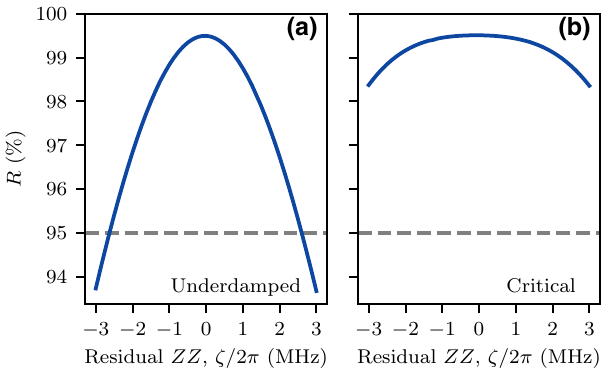
FIG. 8. Sensitivity of the leakage-reduction rate R of the readout-resonator LRU as a function of the overall residual ZZ coupling ζ . (a) Underdamped regime, specifically at the oper- ating point ( (cid:6)/ 2 π ≈ 204 MHz, ω d / 2 π ≈ 5.2464 GHz, t p = 178.6 ns; see Sec. I B). (b) Critical regime ( (cid:6)/ 2 π ≈ 143 MHz, / 2 π ≈ 5.252 GHz, t = 440 ns). ω d p